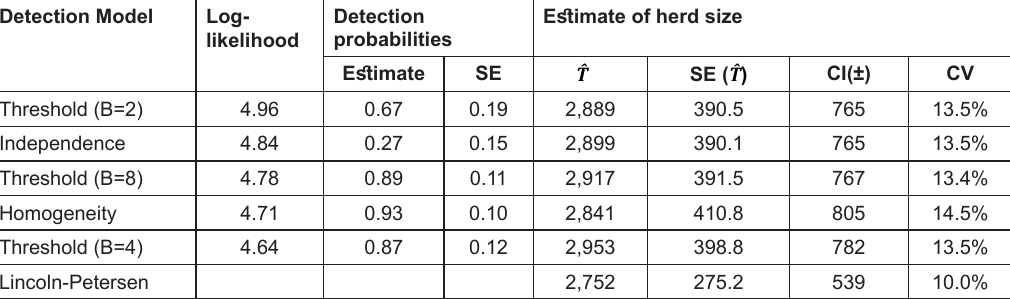
Table 44.Tests for randomness of collars for the 2012 Tuktoyaktuk Peninsula herd survey.